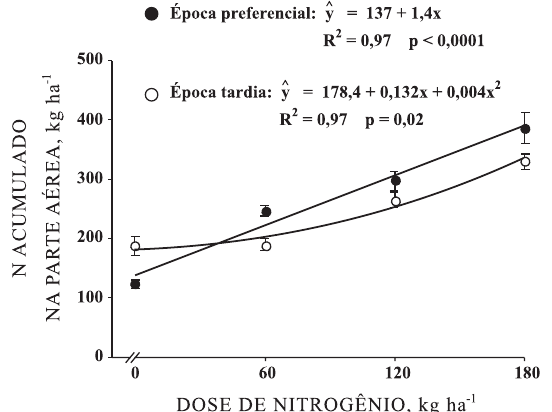
Figura 1. Quantidade de nitrogênio acumulada na parte aérea de planta de arroz irrigado em estádio de emborrachamento para épocas de semeadura preferencial (novembro) e tardia (dezembro), em função da dose de nitrogênio aplicada em cobertura, na média de quatro densidades de semeadura. Barras verticais representam o erro-padrão da média.